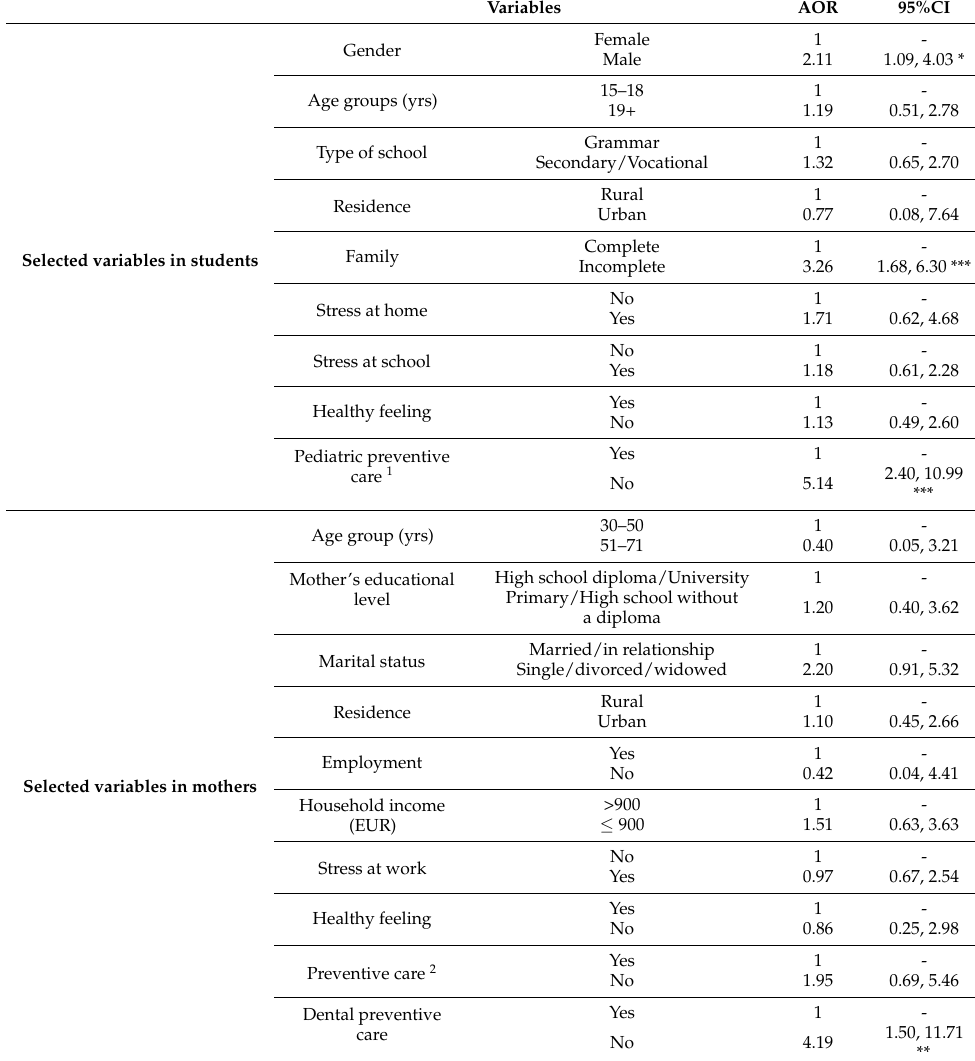
Table 4. Characteristics of selected variables associated with non-attendance at dental preventive care of students in students ( n = 515), mothers ( n = 390), and fathers ( n = 291) multivariate analysis † . Variables AOR 95%CI Gender